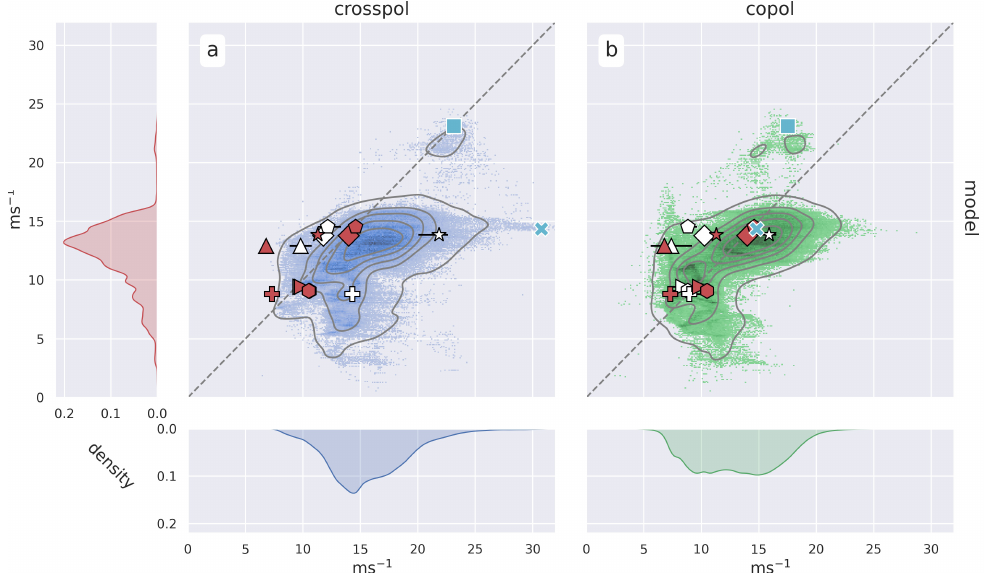
Figure 4. Comparison of retrieved wind speed from the crosspol ( a ) and copol ( b ) wind retrievals shown in Figure2c,d, and collocated wind speed from the AROME-Arctic model. The darker colour shows higher point density, as do the contour lines of the kernel density estimation. The narrow panels on the left and bottom show the associated wind speed distributions. Filled red symbols show weather station observations with the observed wind speed on the horizontal axis and the corresponding model wind speed on the vertical axis. Filled blue symbols with error bars show the mean and variance of the retrieved wind speed within a 3km radius of the weather stations on the horizontal axis against the corresponding model wind speed at the station on the vertical axis. Filled green symbols show the same for the copol